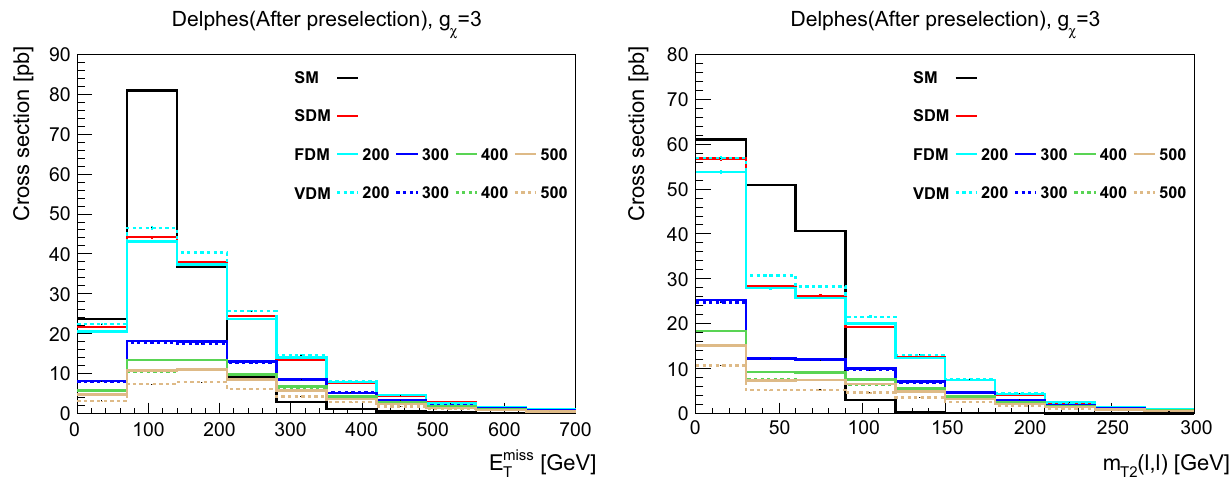
((cid:11),(cid:11)) for signals and background (weighted sum) after the preselections. The distribution of background is Fig. 4 Distributions of E miss and m T T 2 normalized to the actual cross section and those of signals have been 2 × 10 4 times magnified for visibility